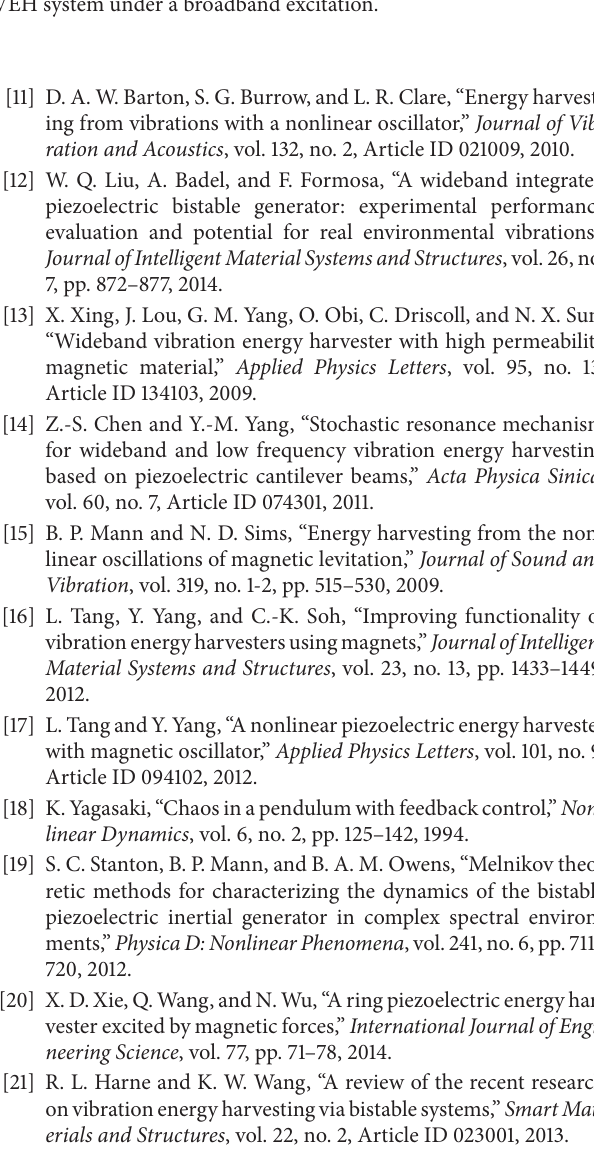
Figure 11: Output voltages of the nonlinear PVEH system under a broadband